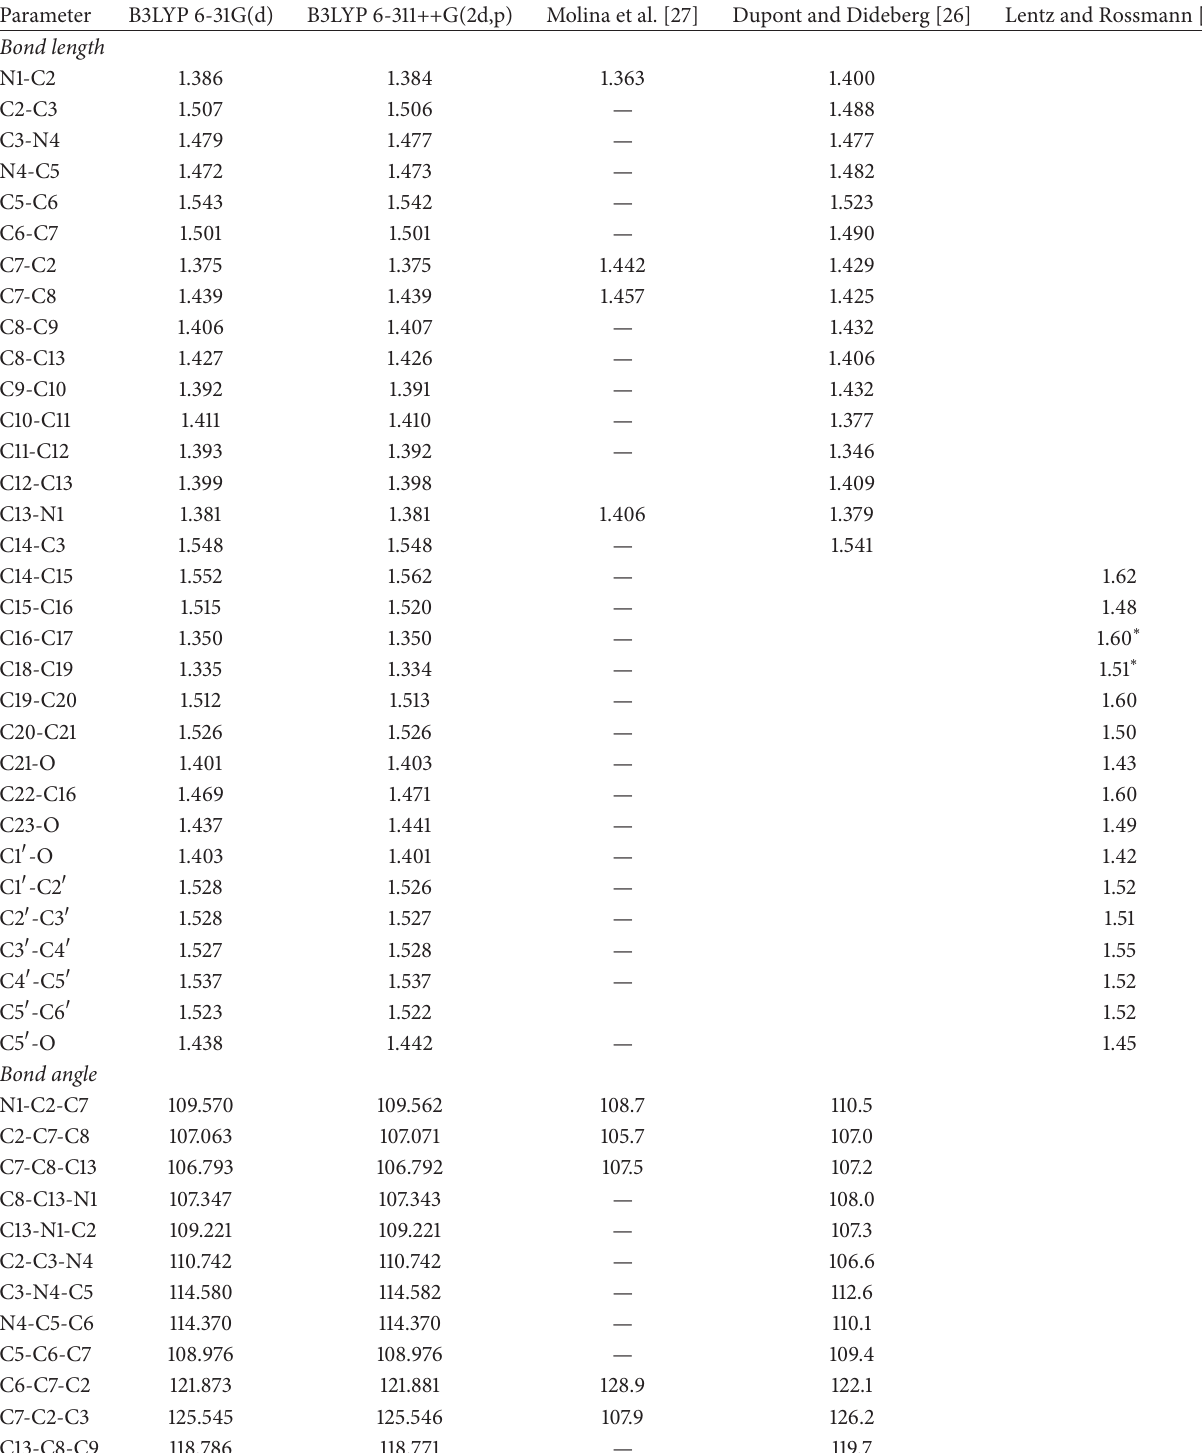
Table 1: Calculated geometrical parameters for strictosidine compared with the experimental